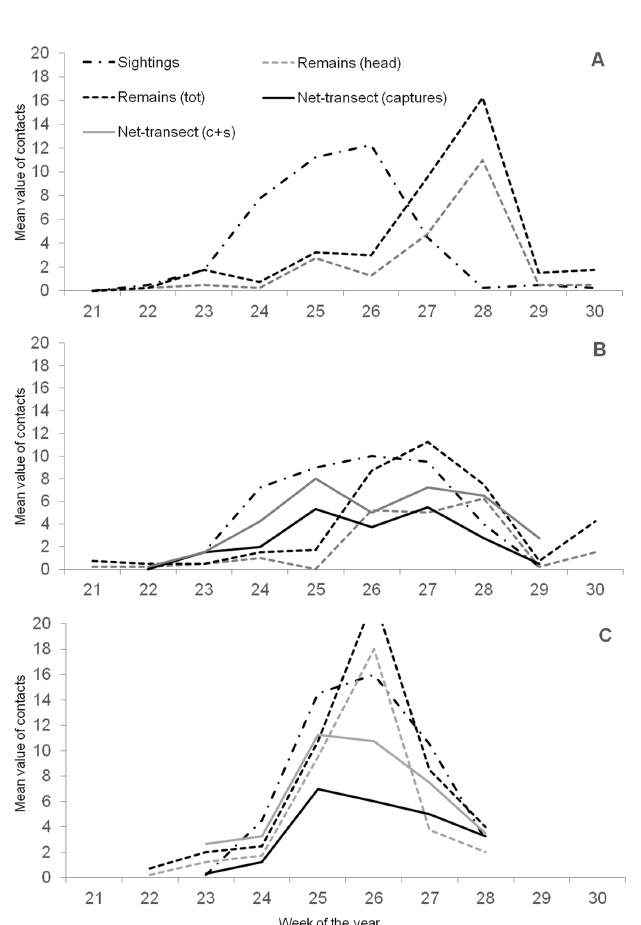
Figure 11. Phenology of the stag beetle L. cervus at Bosco della Fontana during A 2014 B 2015 C 2016. Black dashed-pointed line is the mean value of Sightings; Black dashed line is the mean value of Remains collected along transects; Grey dashed line is the mean value of Remains (heads). Black line is the mean value of captures by Net-transect; Grey line is the mean value of the sum of capture specimens and sight- ings performed by Net-transect. Weeks are expressed as the corresponding week of the year. The mean value of Remains at 26 th week of 2016 is